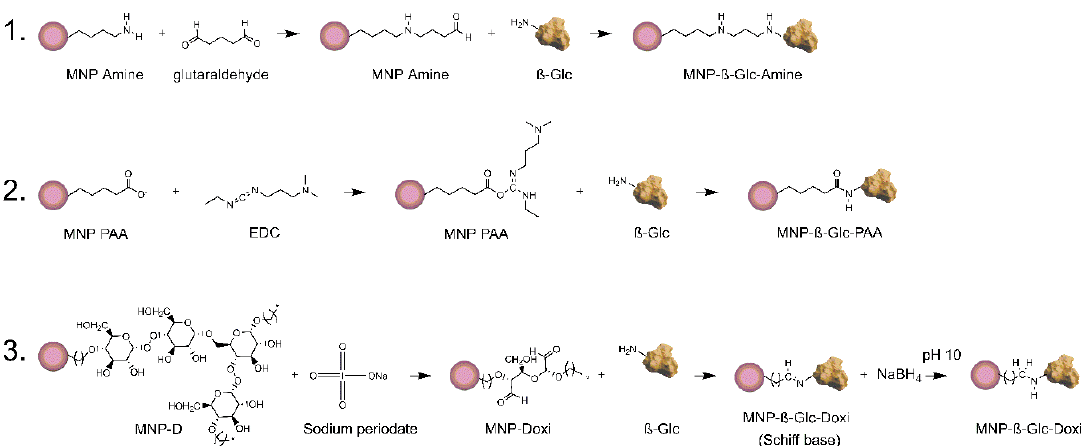
Scheme 2. Schematic representation of the immobilization strategies using differently functionalized magnetic nanoparticles